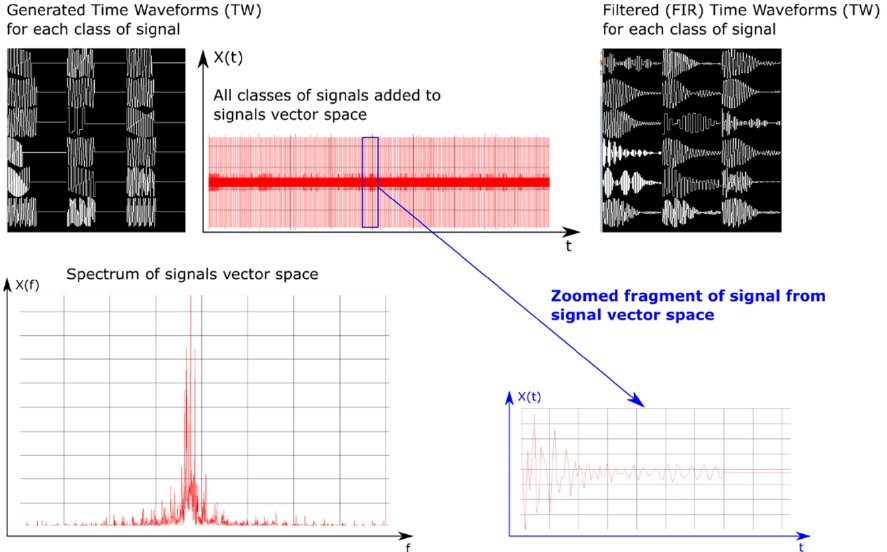
Figure 11. Example of the generation of signals parameters. In the first step, the simulator reads the signal parameters for the given radar devices from the configuration file. Then it should check whether the given hardware configuration allows one to process signals with the maximum sampling frequency obtained from the configuration file. If the system‘s maximum sampling rate is less for random access memory (RAM) than the highest-frequency signal of all signal classes, then the signals (their waveform form) are scaled to the system’s acceptable sampling rate. For faster learning and processing purposes, the scaling rate was chosen manually. After calculating these scaling factors (or setting them manually), the simulator creates the filters with a finite impulse response (FIR) [72,73] for each radar signal class. Filter coefficients for individual classes were calculated based on the Hann‘s time window [74] using the formulas presented in Equations (11)–(13).